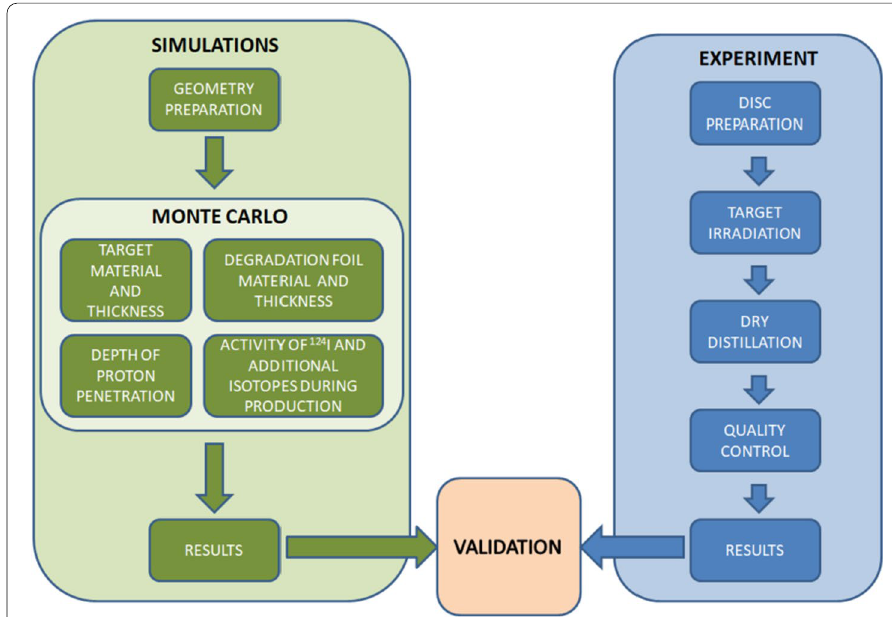
Fig. 1 Flowchart of the Monte Carlo simulations of the 124 I production and the production process experimental